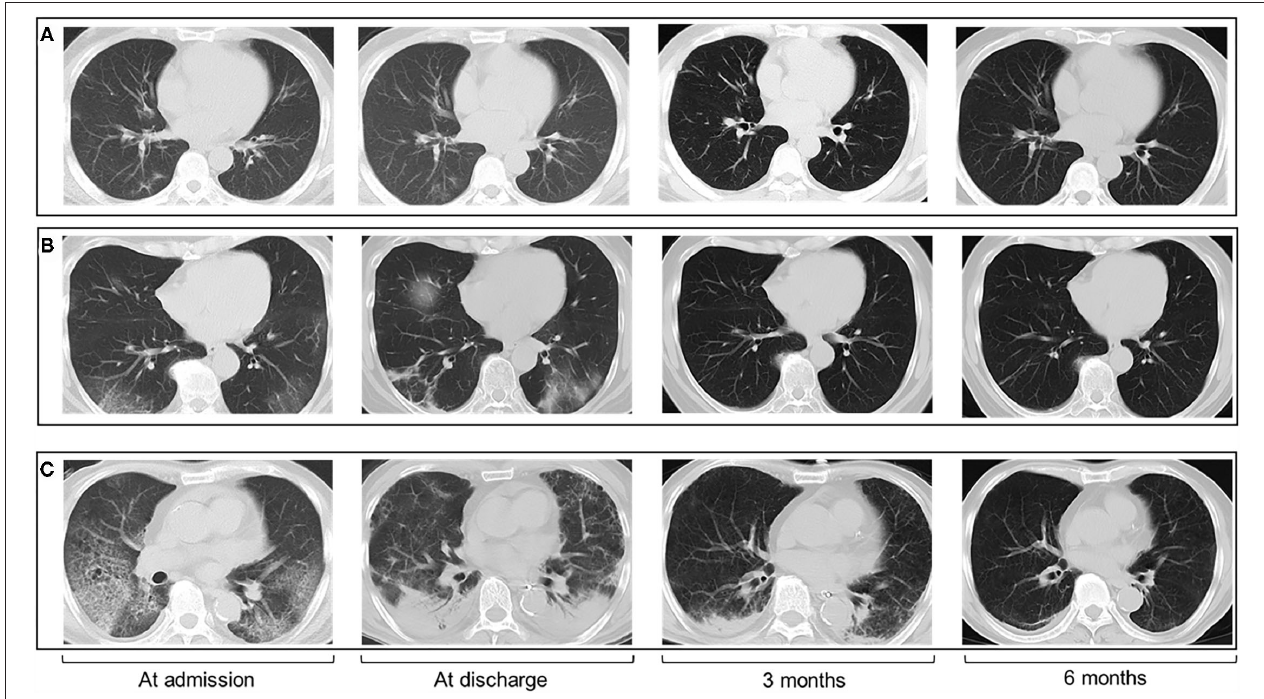
FIGURE 1 | Chest CT images of patients with COVID-19 at four timepoints (admission, discharge, 3 months, and 6 months follow-up). The CT scans show GGO with bilateral lung involvement at admission and patients with greater disease severity had more residual CT abnormalities. (A) CT scans in a 48-year-old man with moderate illness. (B) CT scans in a 55-year-old woman with severe illness. (C) CT scans in a 67-year-old man with critical